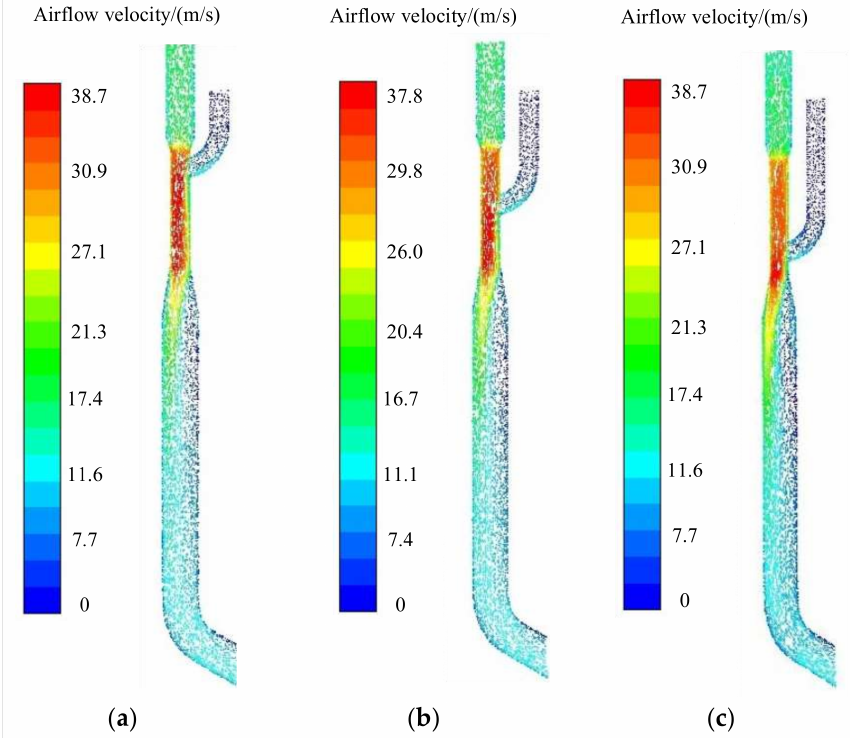
Figure 7. Airflow-velocity contours of intake seed chamber locations. ( a ) Upper, ( b ) central, ( c ) lower.